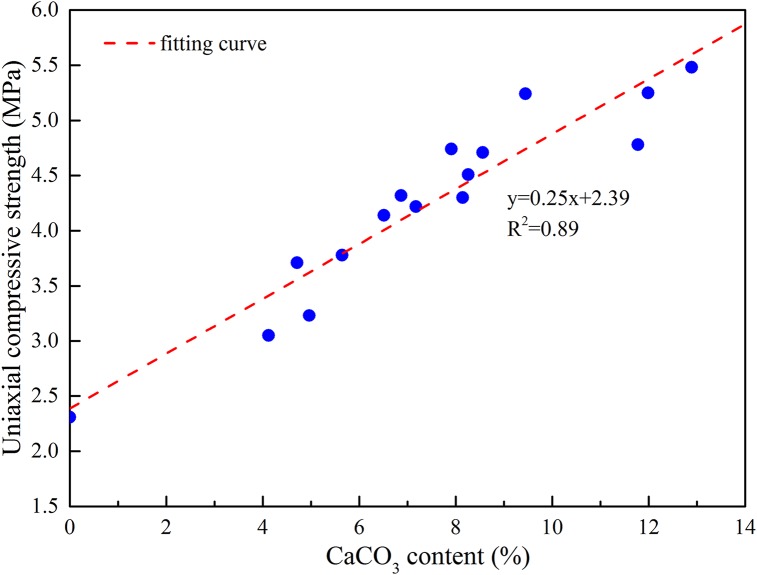
Relationship between uniaxial compressive strength and CaCO3 content.